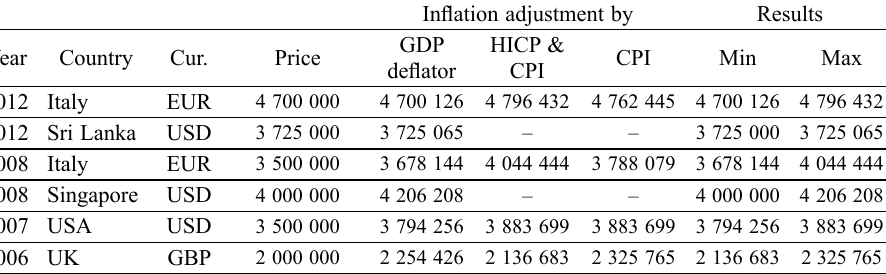
Table 4. Inflation adjustment of estimated prices for tomotherapy units Inflation adjustment by